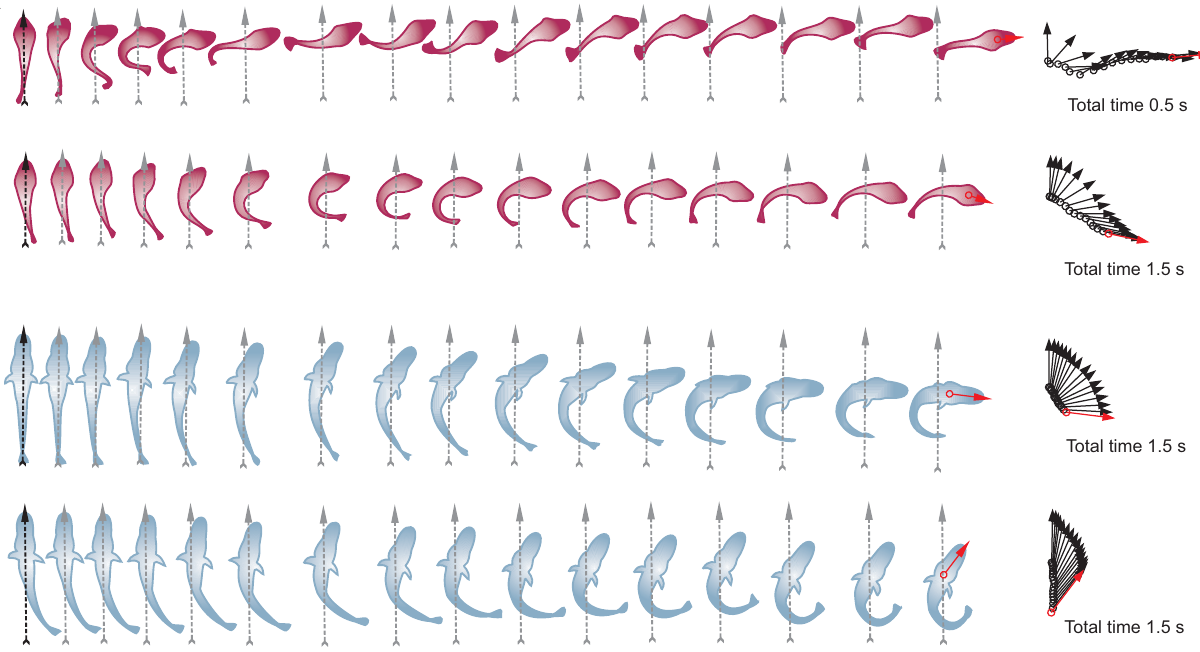
Fig 3. Axial movements during temperature induced startle-like responses in Hb+ N . coriiceps and Hb- C . aceratus . (A) N . coriiceps during an S-bend maneuver shown at 33 ms intervals (at +11.05˚C). (B) N . coriiceps during a C-bend turn shown at 100 ms intervals (at +12.4˚C). (C) C . aceratus during a C- bend turn shown at 100 ms intervals (at +8.5˚C). (D) C . aceratus during a withdrawal-like maneuver shown at 100 ms intervals (at +11.5˚C). In all panels, ventral views (pectoral fins not shown) are depicted. Gray vertical arrows indicate the position of the midline at the beginning of turning maneuvers. Arrow diagrams on the right depict of the head orientation during turns, at time intervals indicated above. Each arrow connects the position of the fish nose with the center of mass. Red arrows indicate final direction of locomotion.